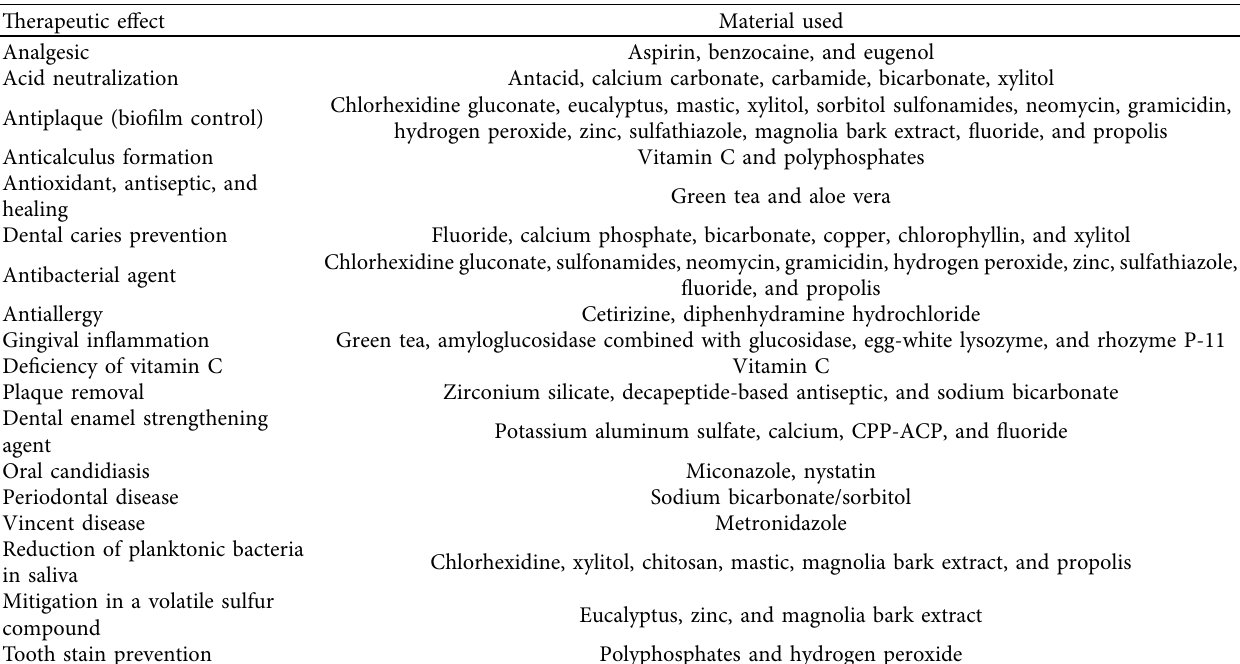
Table 2: Therapeutic effects and materials used in chewing gum on oral